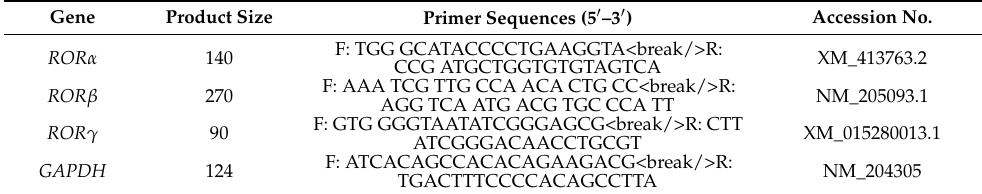
Table 2. Sequences of primers used for